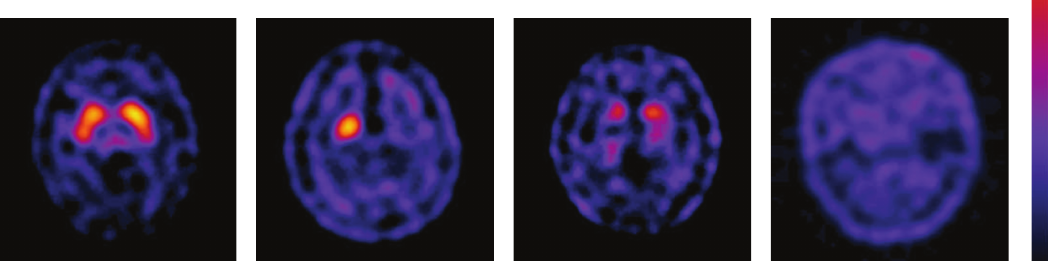
Figure 1: 99m Tc-TRODAT-1 imaging on four patients with Parkinson’s disease at di ff erent stage and one normal control. The di ff erentiation between normal and PD is primarily based on shape that reflects di ff erences of uptake